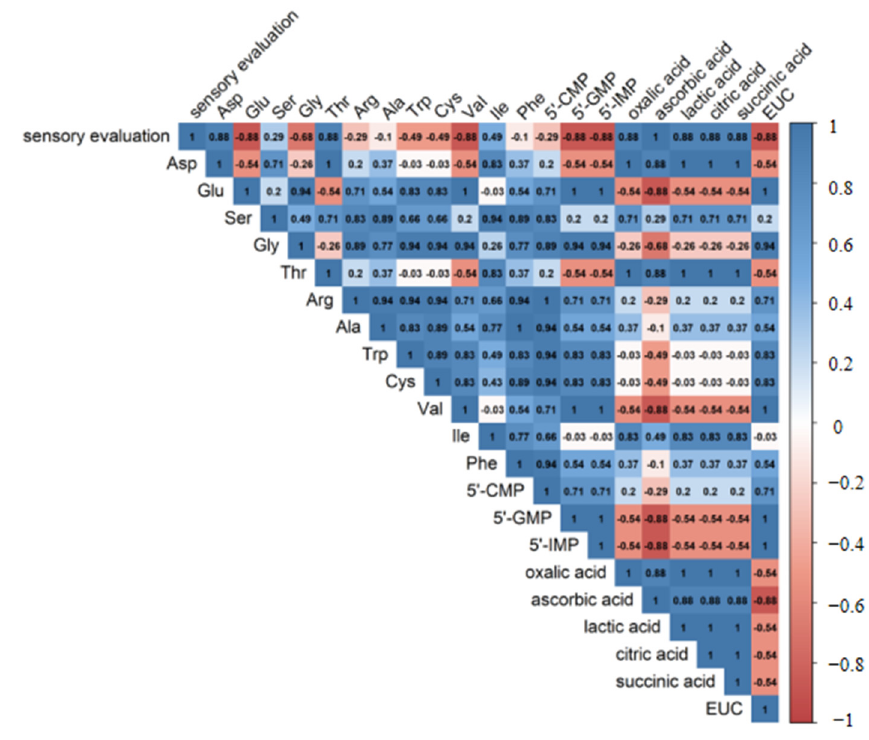
Figure 2. The results of Spearman correlation analysis.